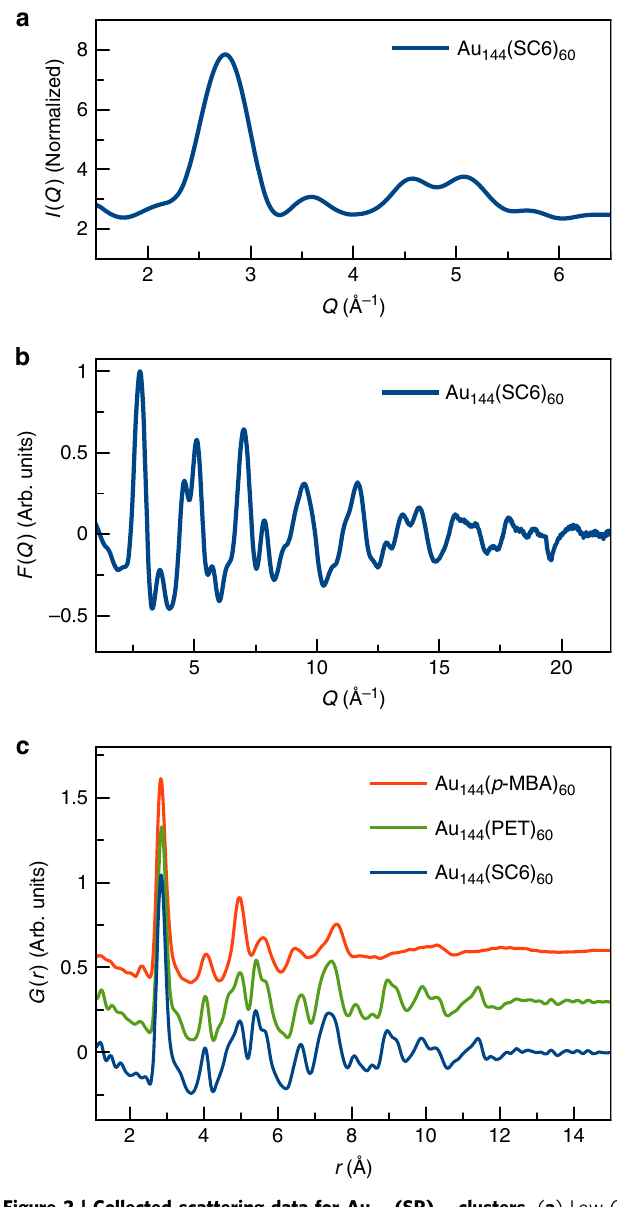
Figure 2 | Collected scattering data for Au 144 (SR) 60 clusters. ( a ) Low Q scattering data, corresponding to the conventional XRD signal for the Au 144 (SC6) 60 sample. ( b ) Total scattering structure function F ( Q ) for Au 144 (SC6) 60 . ( c ) PDFs obtained from Au 144 (SC6) 60 , Au 144 (PET) 60 and Au 144 ( p -MBA) 60